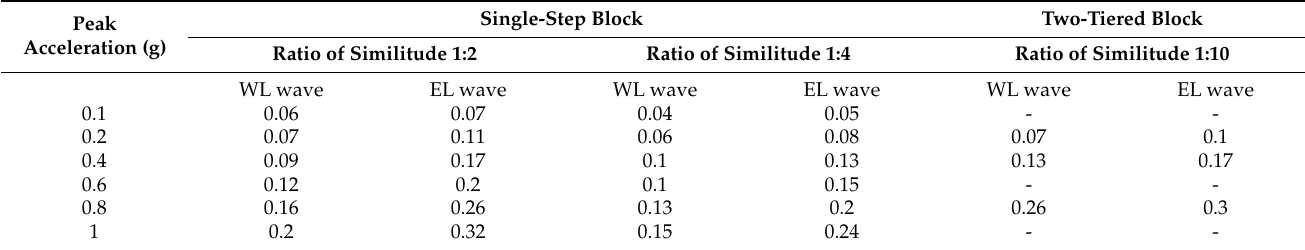
Table 5. Peak velocity values of the reinforced soil retaining wall of the single-step module and two-tiered module Vm (m/s). Peak Acceleration (g)